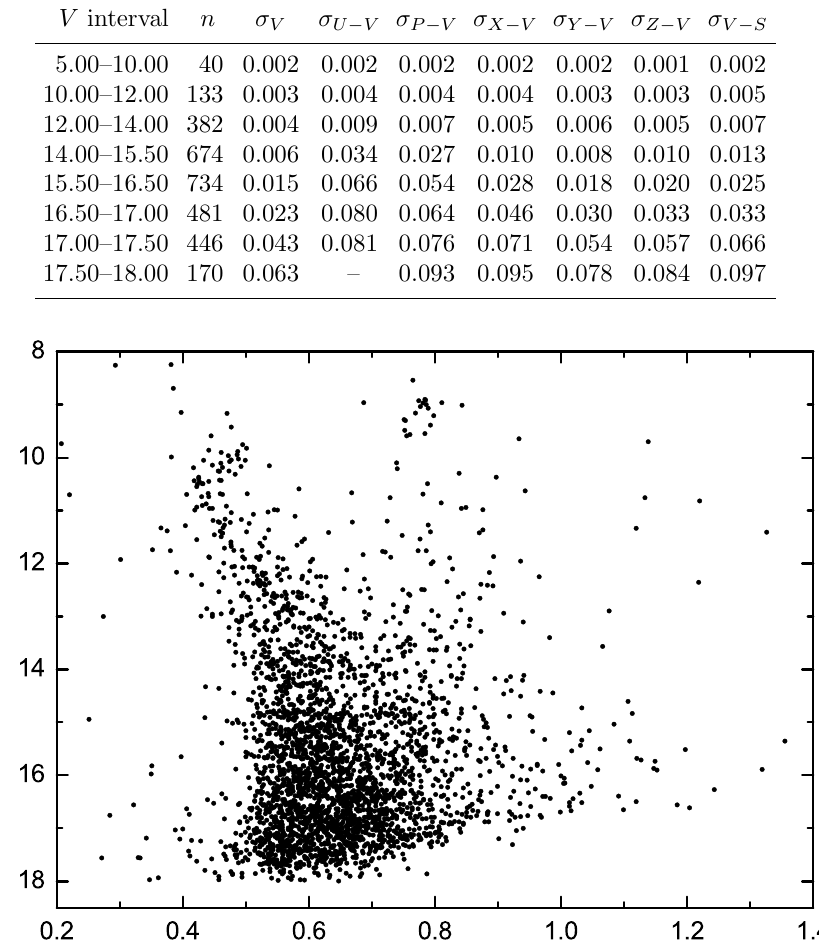
Table 2. Internal accuracy of the photometric catalog.